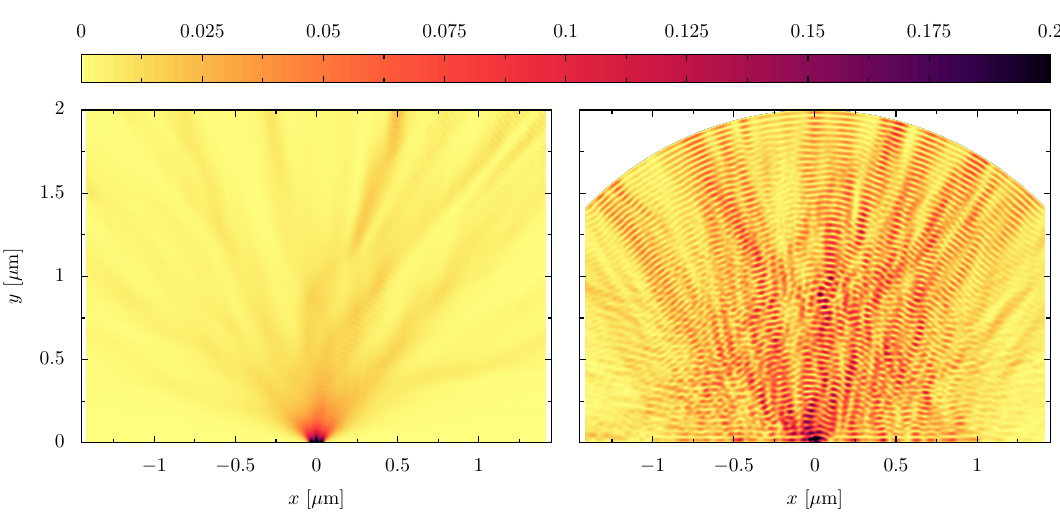
( x , y ) at an energy 1 E